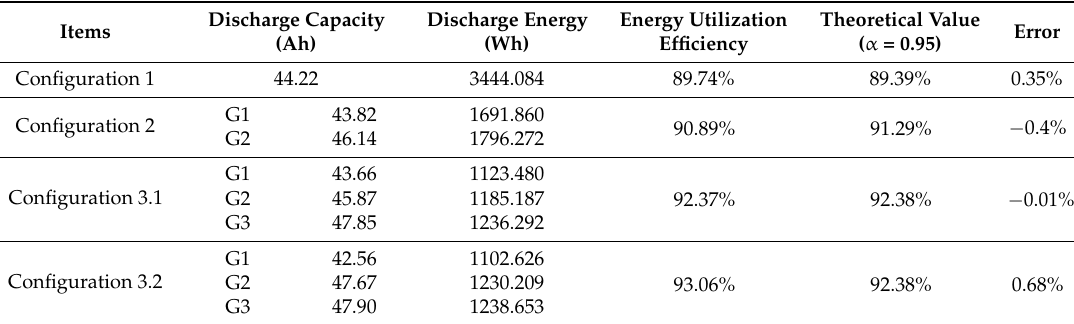
Table 5. Experiment 1